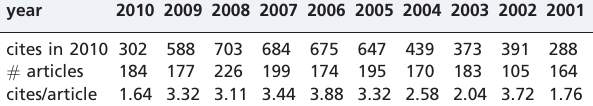
Table 3 - Data derived from the Half-life table for Shock, 2010 (lines 1 & 2) to which lines 3 and 4 were added using data from the ISI JCR. 1